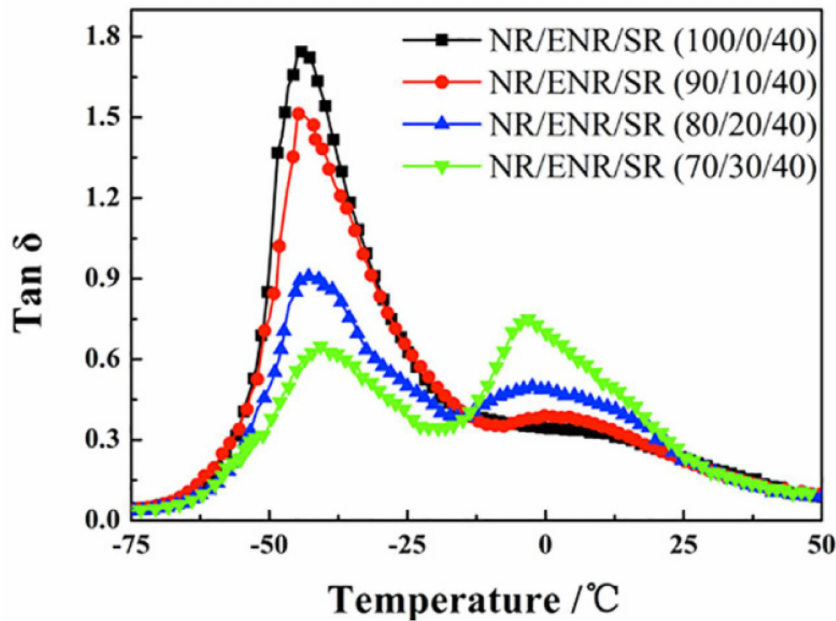
Figure 15. Temperature dependence of the damping loss factor (tan δ ) of ternary NR/ENR/SR rubber composites [48].